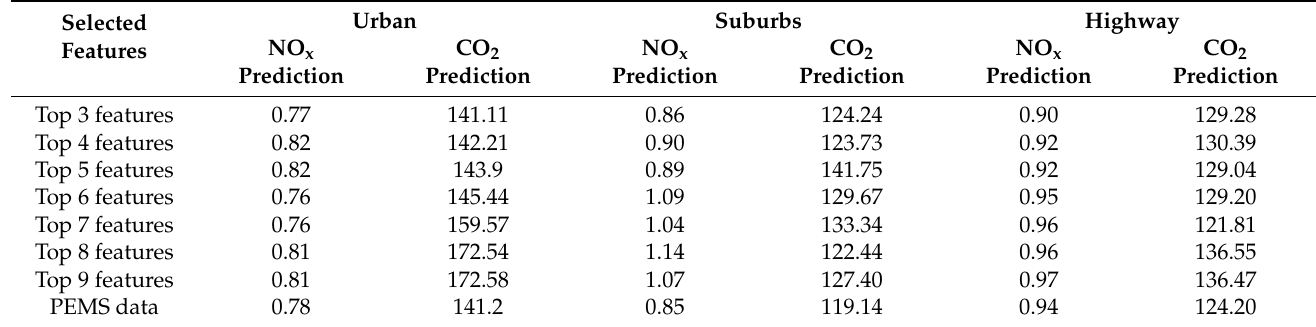
Table 15. Second Route NO x and CO 2 emission g/km predictions statistics results of using route 1 urbanmodels. Selected Features